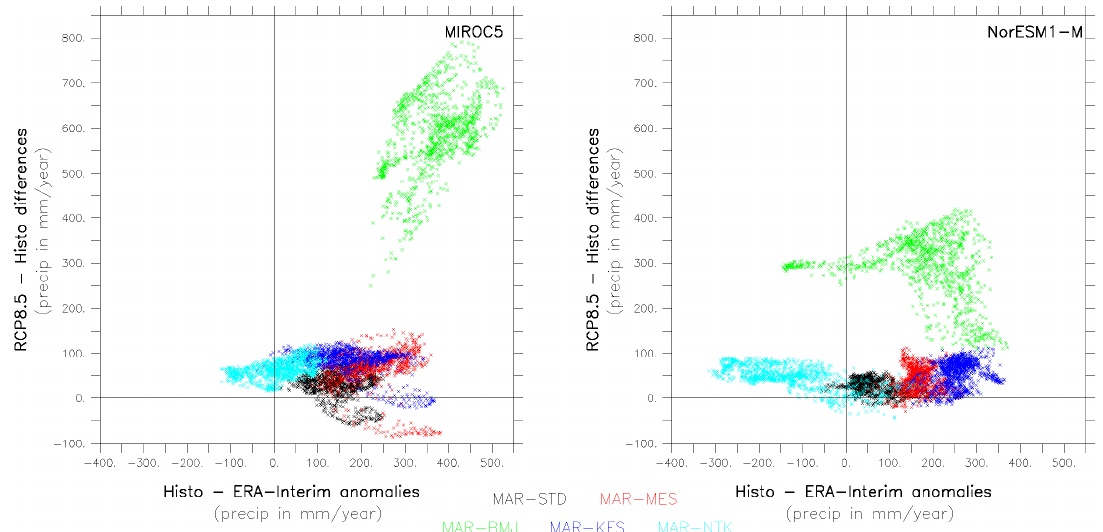
Figure 6. Mean present anomalies (Histo-ERA-Interim) of annual precipitation (mm/year) versus future differences (RCP8.5-Histo) of annual precipitation (mm/year) for each pixel of the Belgian domain of MAR forced by the GCMs MIROC5 (left) and NorESM1-M (right). Each color represents the MAR version depending on the convection scheme used. “Histo” and “ERA-Interim” correspond to the present-day simulation period (1987-2017) when MAR is forced by both GCMs based Historical scenarios or by the ERA-Interim reanalysis.